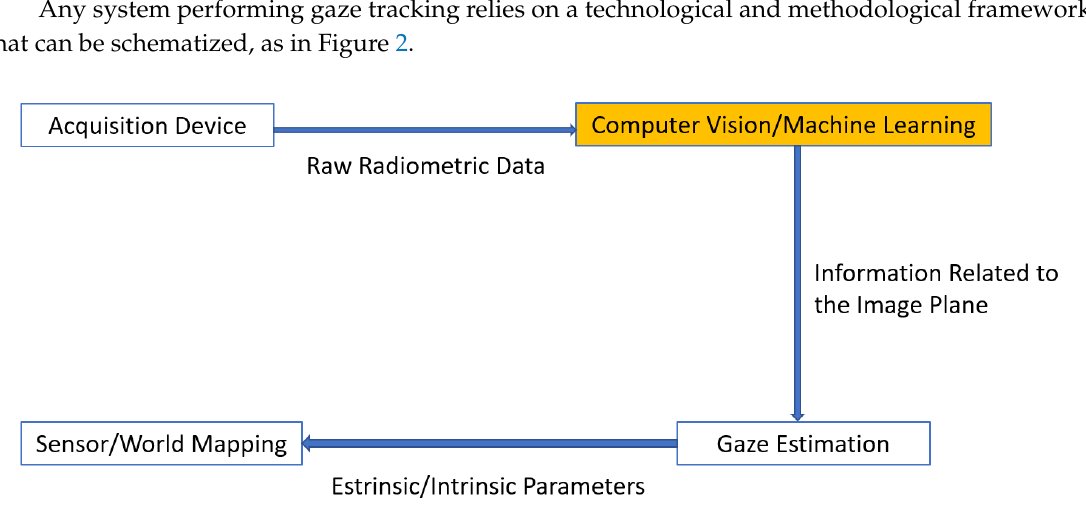
Figure 2. A block diagram of a typical gaze estimation